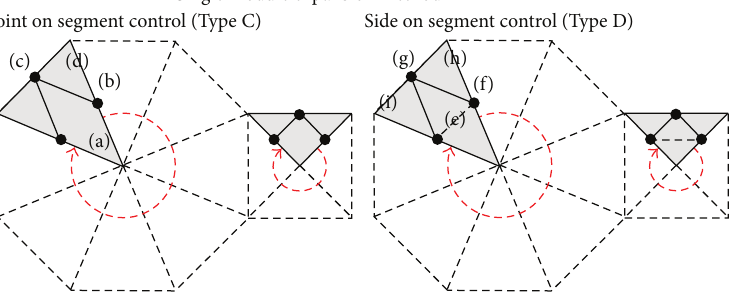
Figure 25: Single module expansion method diagram.